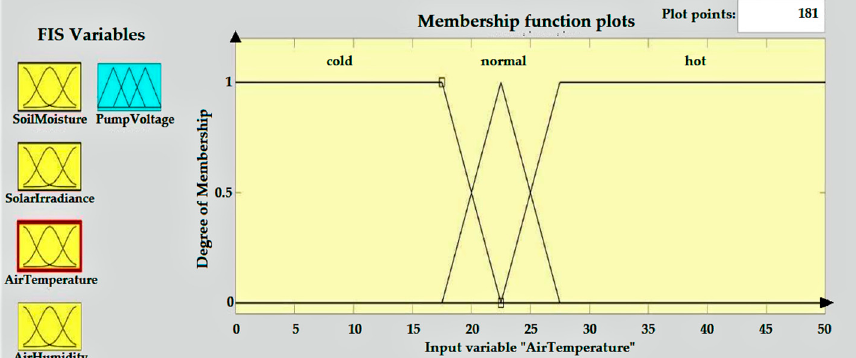
Figure 5. Air temperature membership function plot.